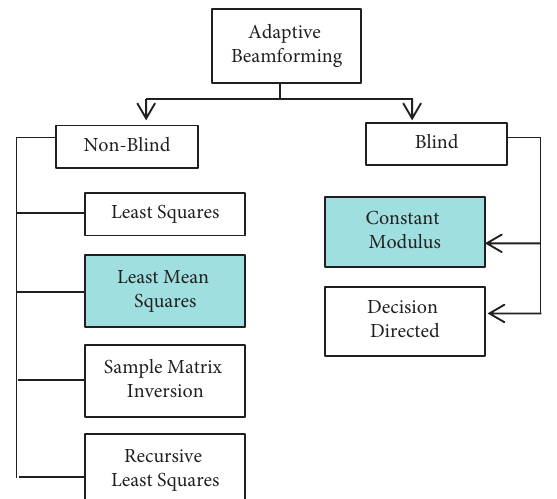
Figure 1: Algorithm types of adaptive beamforming.